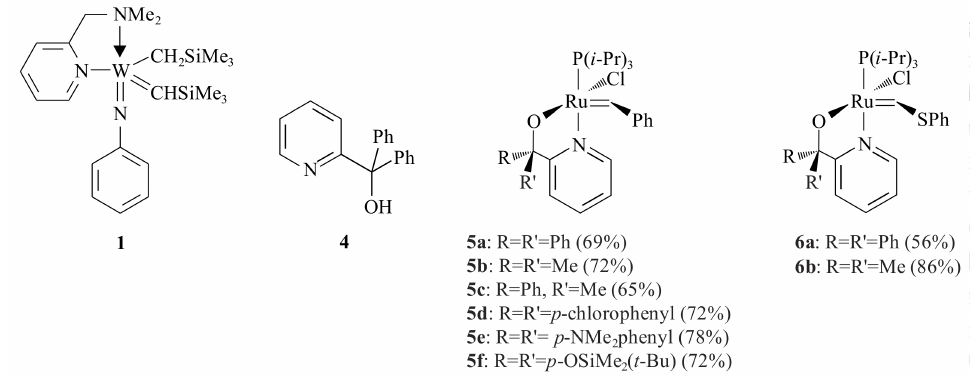
Figure 1. N , N - and N , O -bidentate metathesis